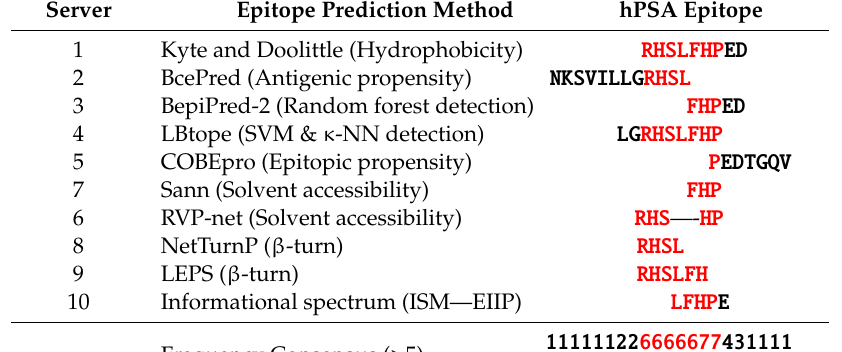
Table 2. Prediction of hPSA epitope RHSLFHP was obtained using 10 epitope prediction methods.